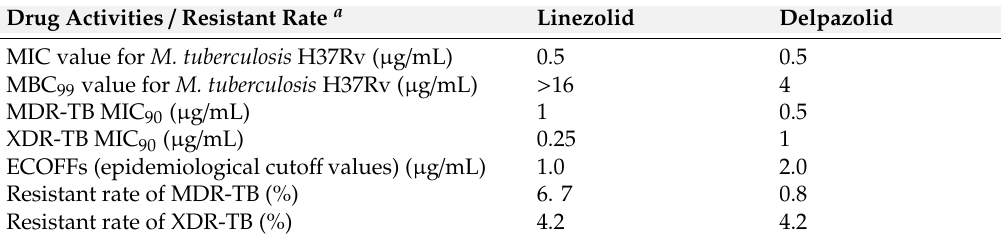
Table 5. Drug activities and resistance rates of linezolid and